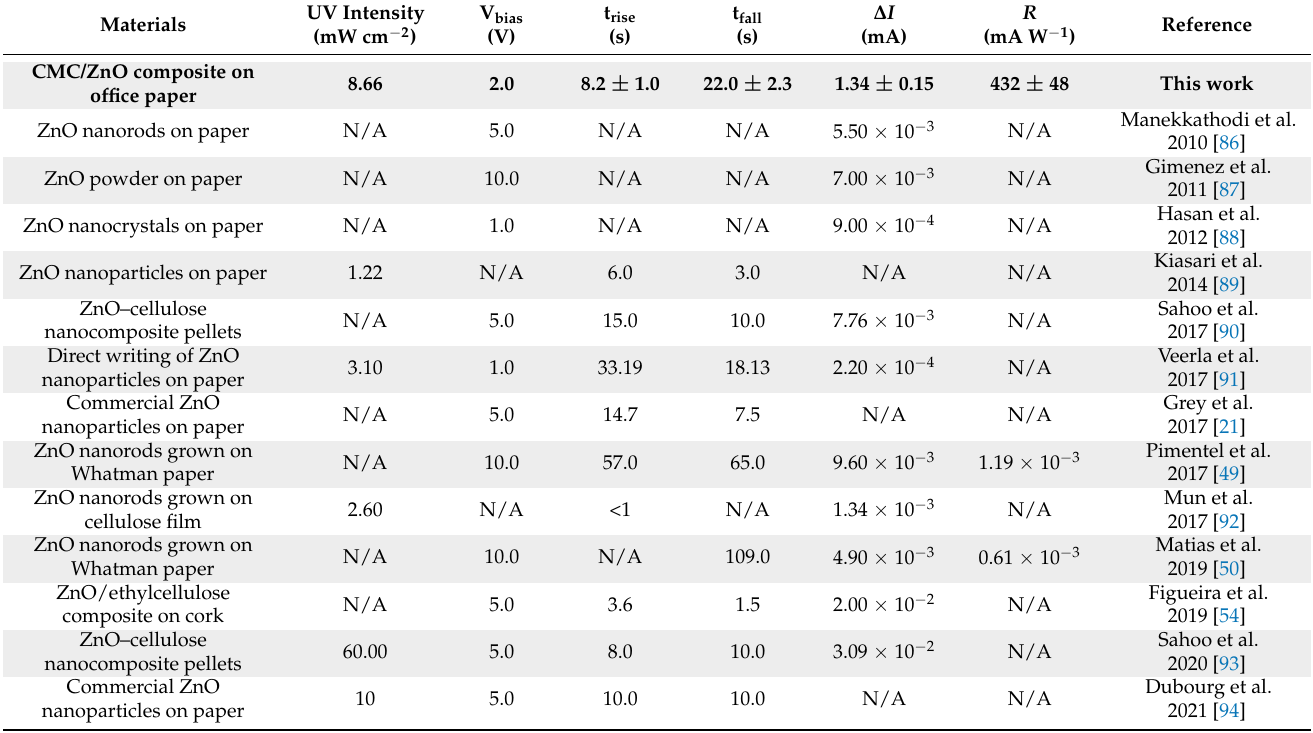
Table 1. Comparison of typical measurement parameters ( V bias and UV light intensity) and respective UV sensor character- istics ( t rise , t fall , ∆ I , and R ) obtained for devices based either on ZnO nanostructures grown/deposited on paper substrates or ZnO/cellulose